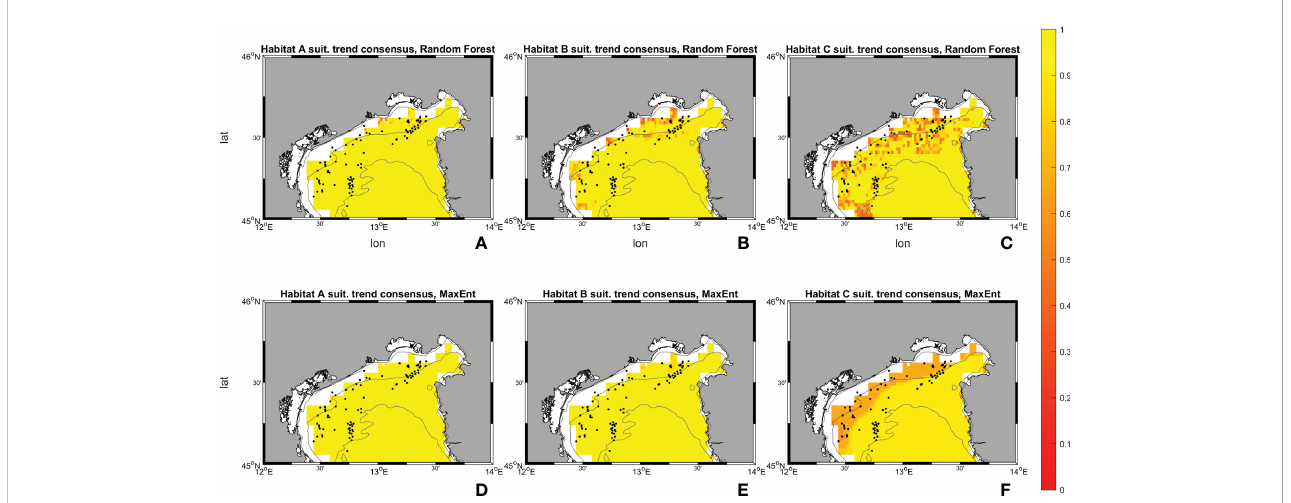
FIGURE 13 Consensus between trends sign in the sensitivity analysis and the SCE run for Random Forest (A – C) and for MaxEnt (D – F) . For each simulation, agreement is assessed based only on the sign (either increasing or decreasing) of the trend. The scale ranges from 0 (worst agreement, no simulation in the sensitivity analysis in agreement with SCE) to 1 (perfect agreement, all simulations in agreement with SCE).